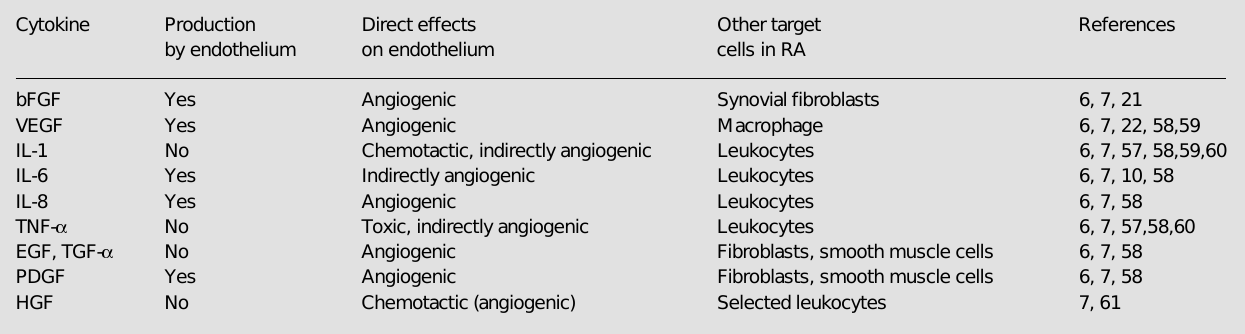
Table 1 - Selected angiogenic cytokines present in RA. Selected cytokines found in rheumatoid arthritis synovial tissues which have been associated with angiogenesis in vivo . Each cytokine listed is classified with respect to possible production by, and characterized effects on, endothelial cells. References discussing the potential role of each cytokine in RA are